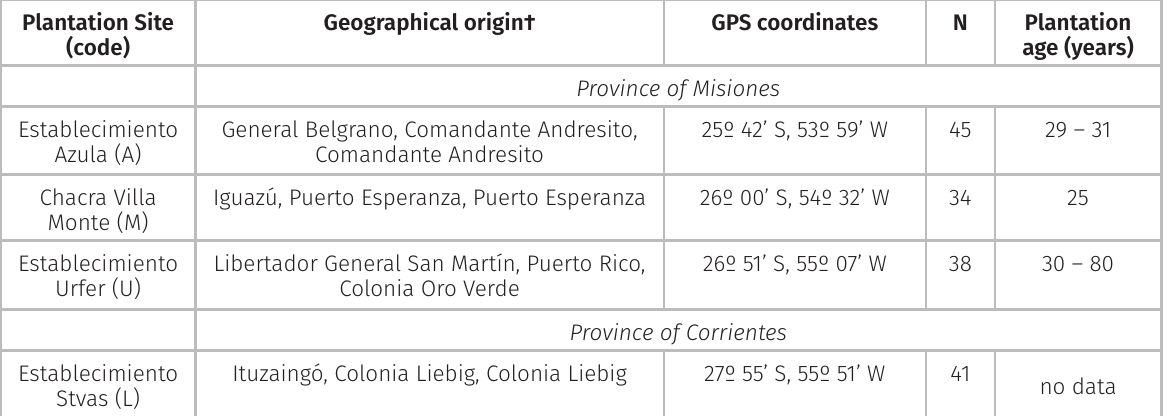
Table I. Details on the Ilex paraguariensis materials used for molecular characterization. Plantation Site (code)